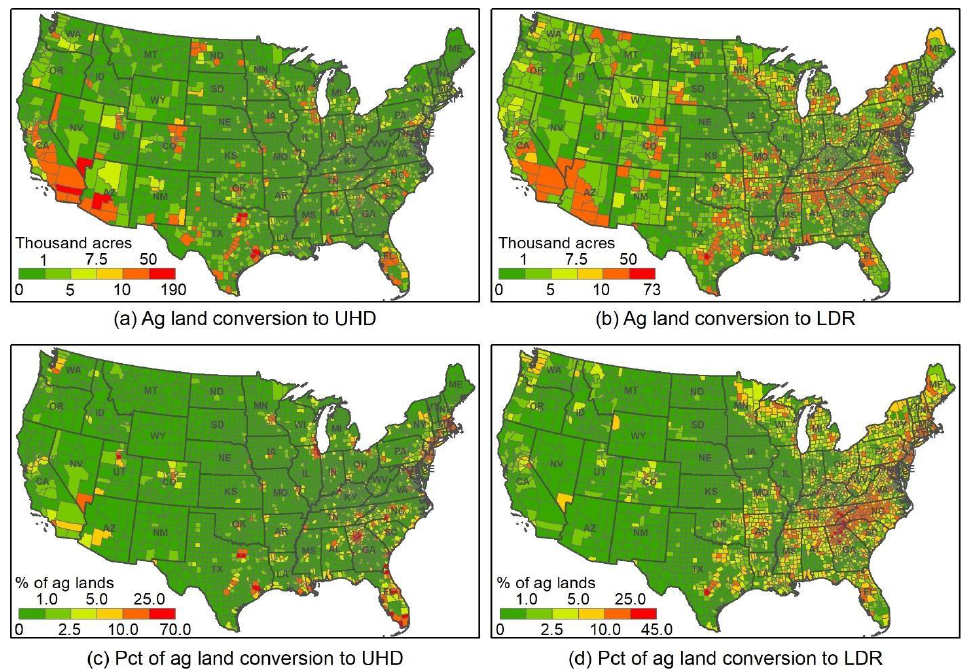
Figure 10. Per-county area and percent of agricultural lands converted to urban and highly developed (UHD) and low-density residential (LDR) land uses by 2040. ( a ) area of agricultural land conversion to UHD, ( b ) area of agricultural land conversion to LDR, ( c ) percentage of agricultural land conversion to UHD, and ( d ) percentage of agricultural land conversion to LDR.